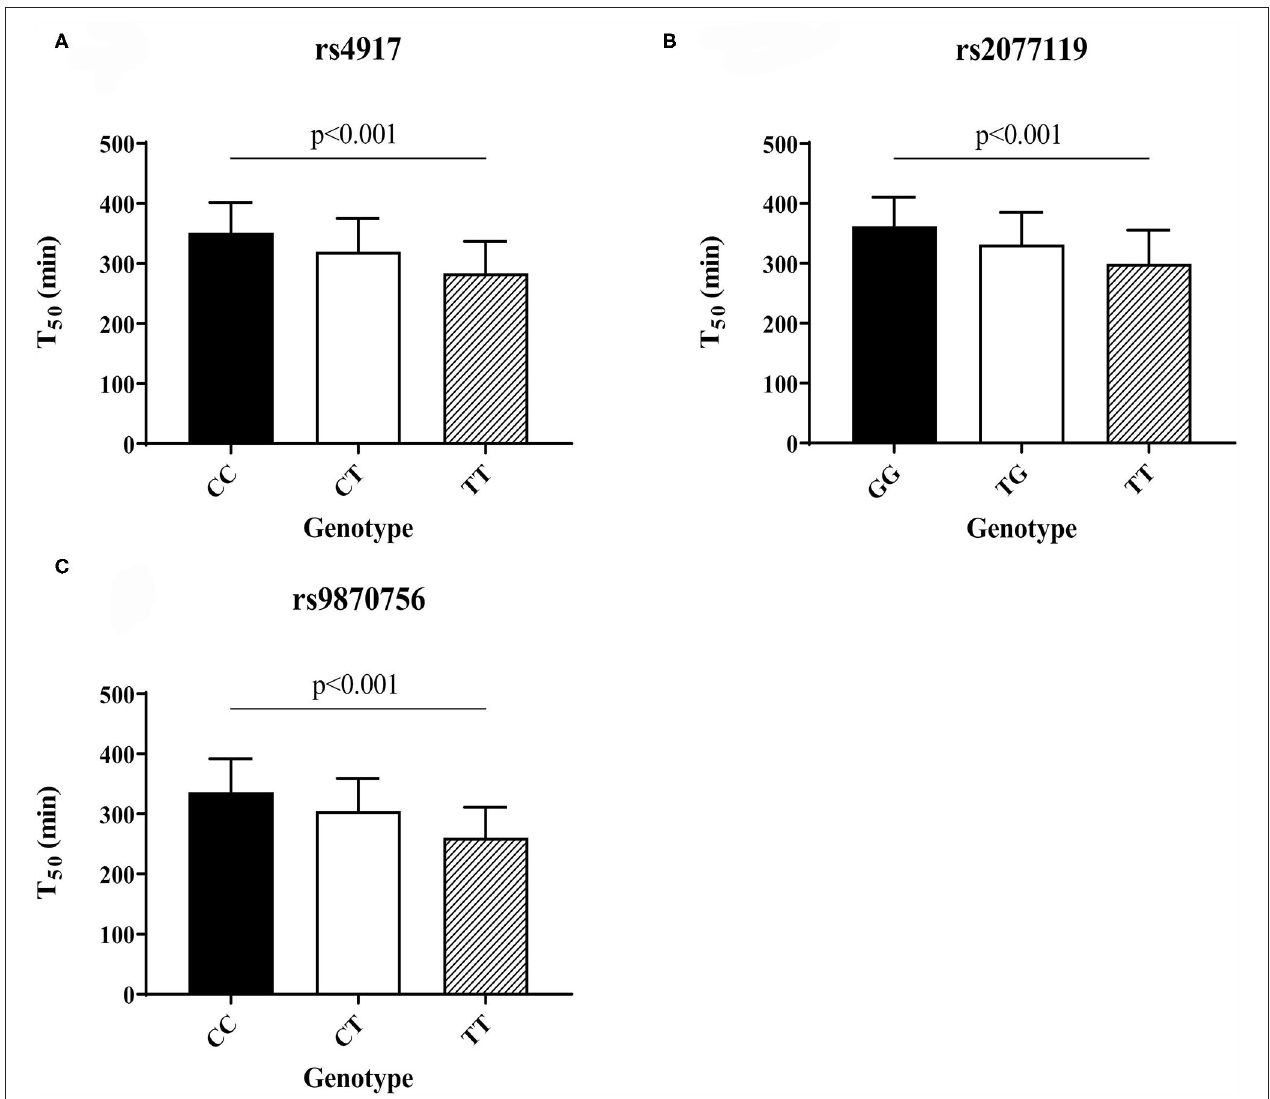
FIGURE 2 | Serum T 50 values for the different genotypes of the three independent T 50 SNPs in the PREVEND cohort: (A) rs4917, (B) rs2077119, (C) rs9870756. Differences between genotypes calculated with ANOVA and post-hoc